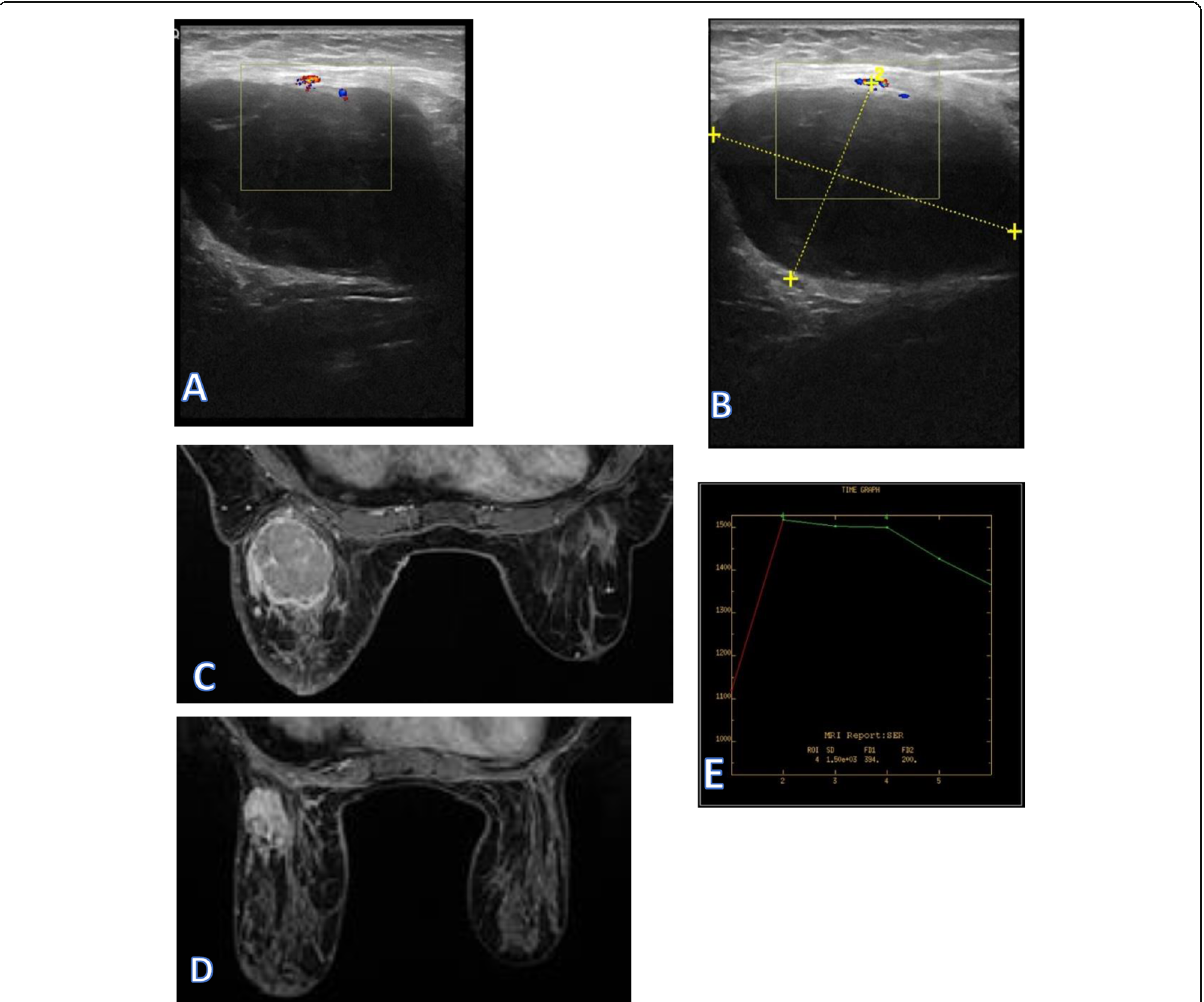
Fig. 6 A 24-year-old patient complains of right breast lump. a and b US revealed right axillary tail large complex hypo echoic lesion with area of breakdown, slightly micro-lobulated margin, and mild echogenic halo boundary is noted (BIRADS V classification). c – e MRI revealed that the mass shows rim enhancement with rapid washout (type III enhancement pattern in kinetic time intensity curve) (category V according to MRI LEXICON classifications). Biopsy revealed intraductal